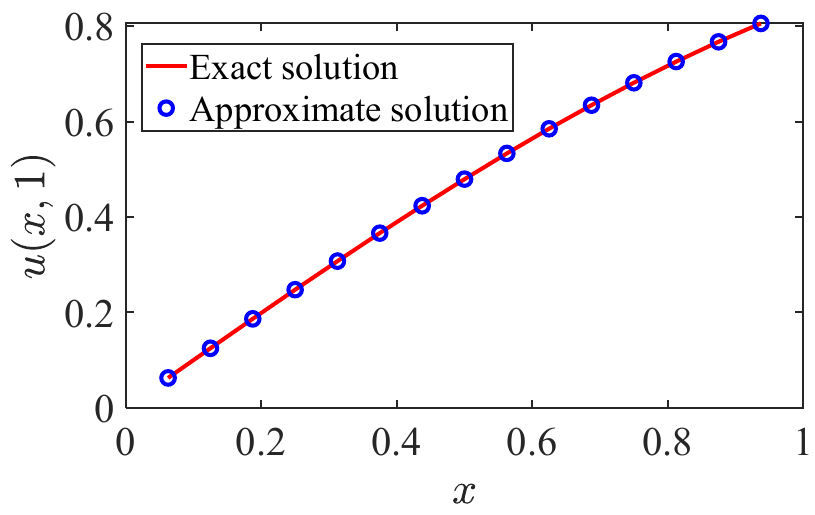
Figure 4. The present solution at t = 1 for Example 3 with α =